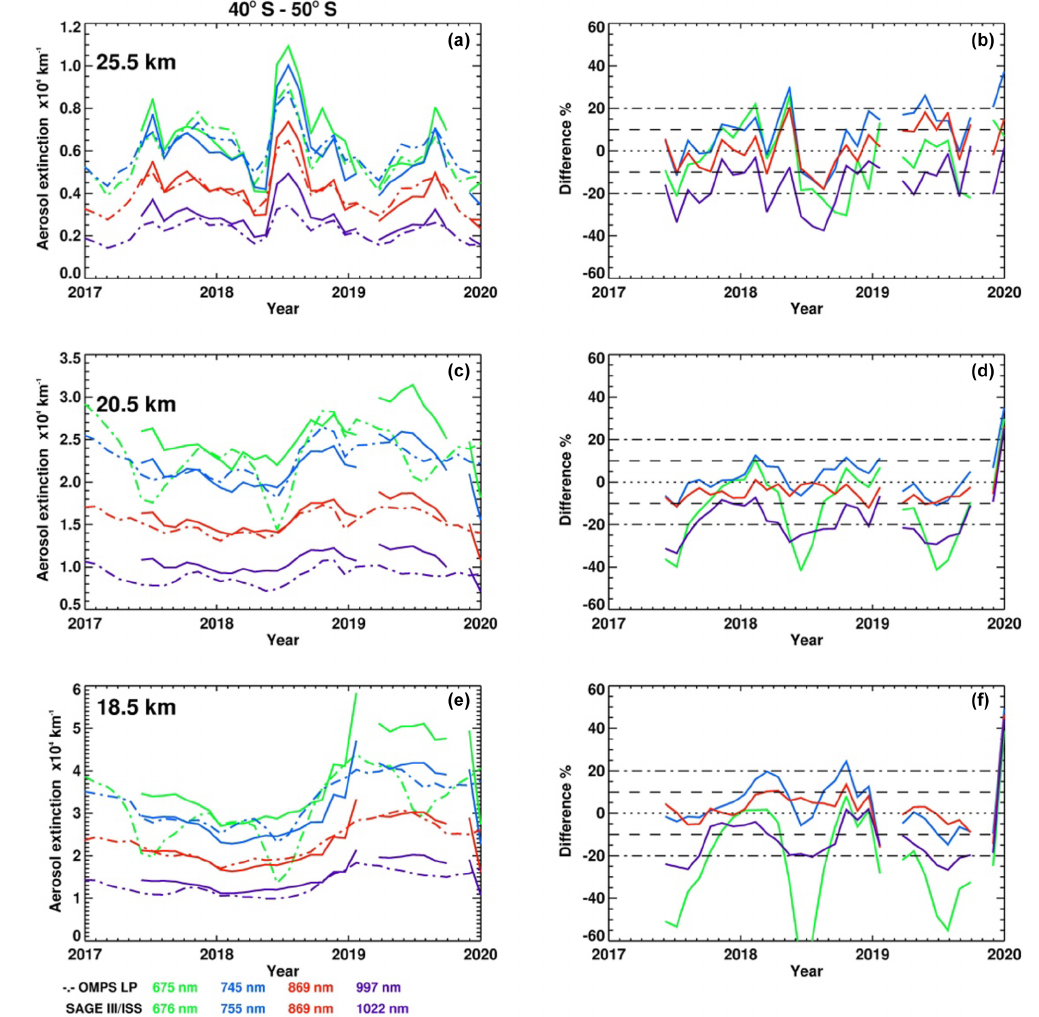
Figure 9. Panels (a) , (c) and (e) are OMPS LP (dashed) and SAGE III/ISS (solid) aerosol extinction monthly zonal mean at 675, 745, 869 and 997nm, latitude zone 40–50 ◦ S for altitudes 25.5 (top), 20.5 (middle) and 18.5km (bottom), from 2017 to 2019. Panels (b) , (d) and (f) are the percent